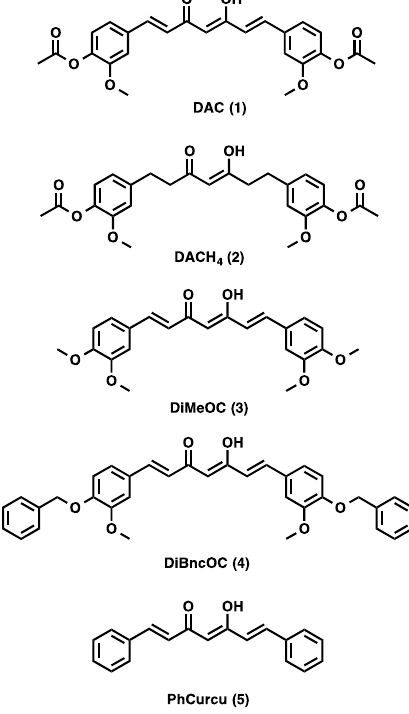
Figure 1. Ligands used for complexation with copper 1 – 5 .